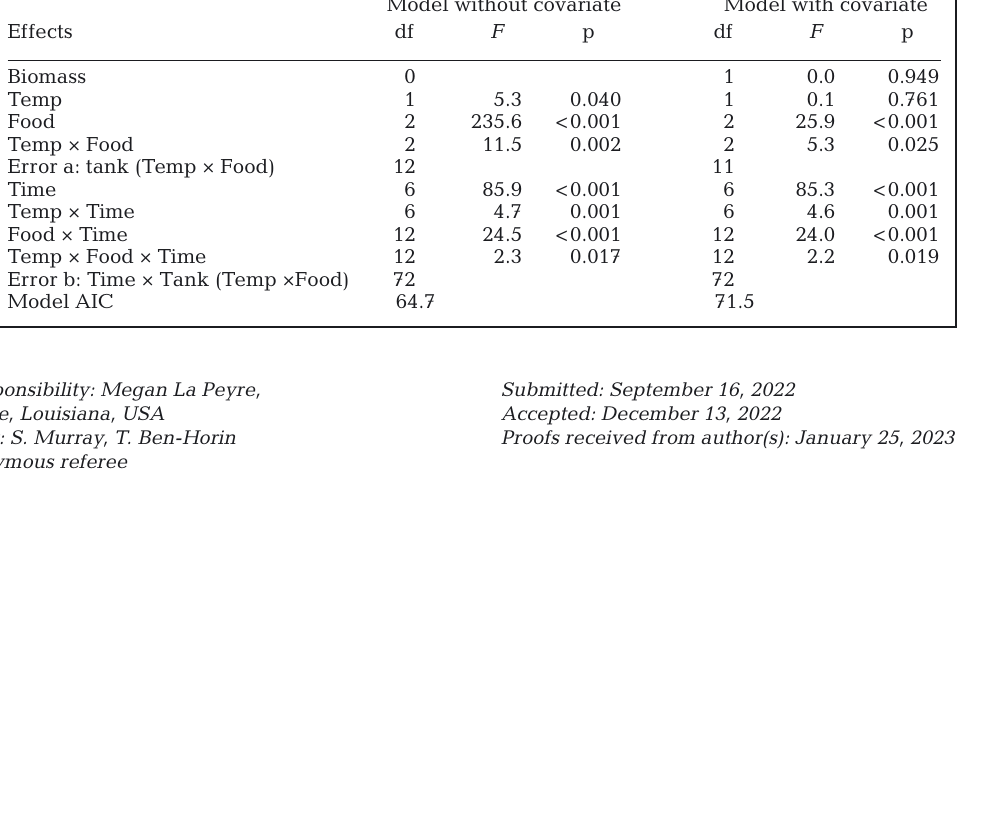
Table A2. Generalized linear mixed-effects model selection used to assess the effects of temperature (Temp, 16.5°C vs. 22°C), food level (starved, low and high), and time on levels of OsHV-1 DNA in sea- water at the tank outlet. Data were log ( x + 1) Model without covariate Model with covariate Effects